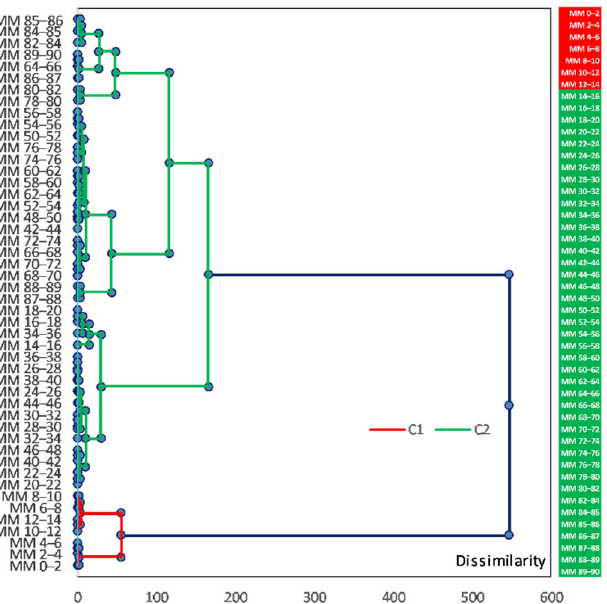
Figure 28. Dendrogram showing the clustering and vertical distribution (on depth) for the sediment sections of Movila Miresii Lake.